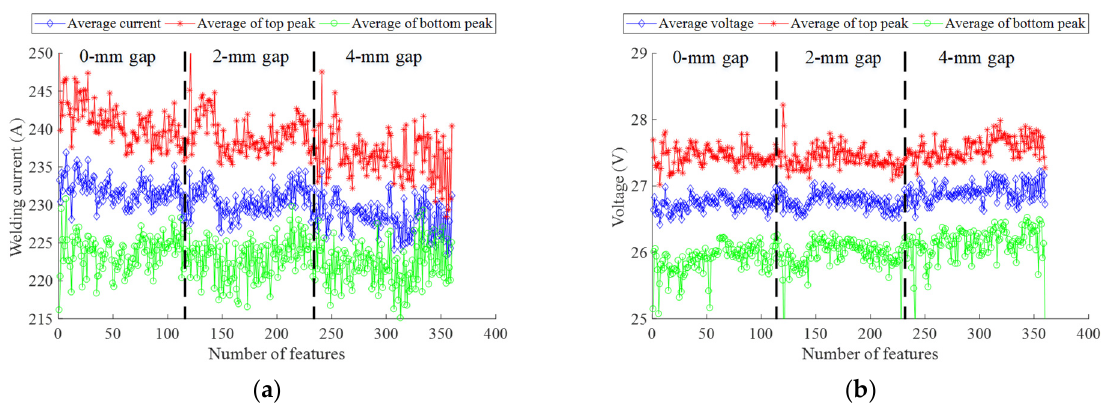
Figure 5 . Time domain feature variable visualization: ( a ) distribution of current feature variables according to the weld gap change and ( b ) distribution of voltage feature variables according to the weld gap change.